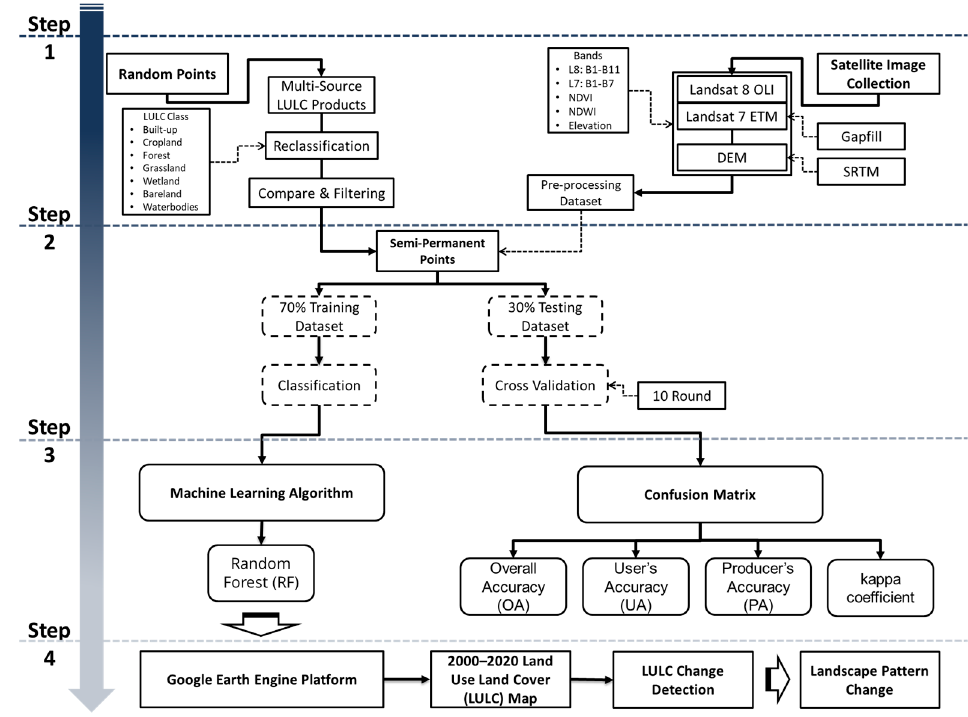
Figure 2. Research process flow chart.